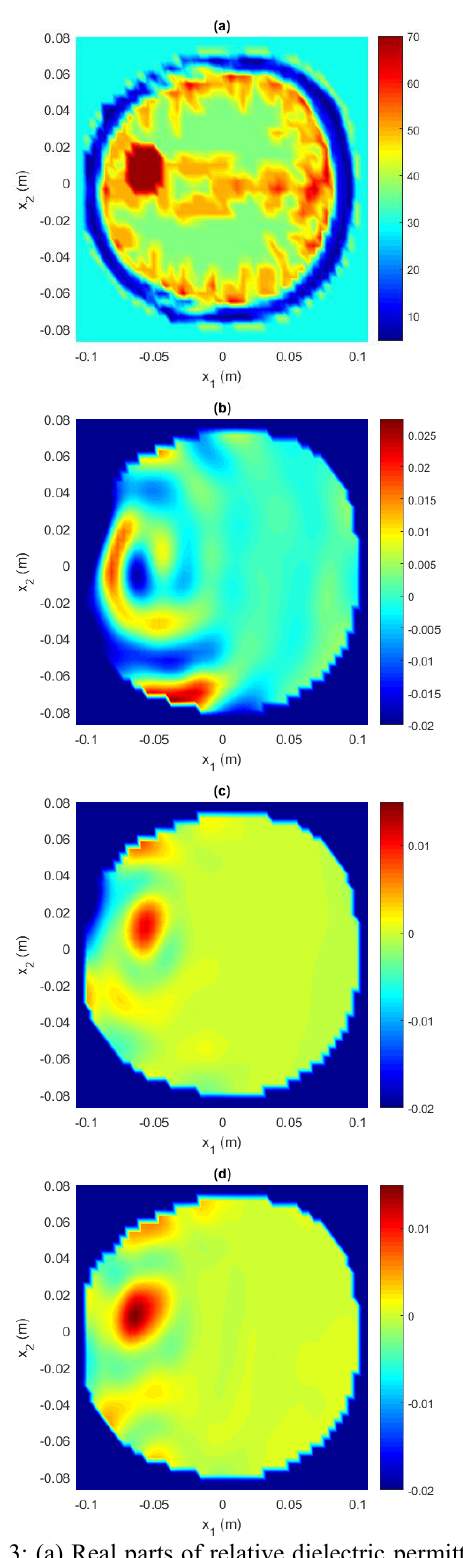
Figure 2: Variations of relative dielectric permittivity of 2-D head model (a) Real Part, (b) Imaginary Part.